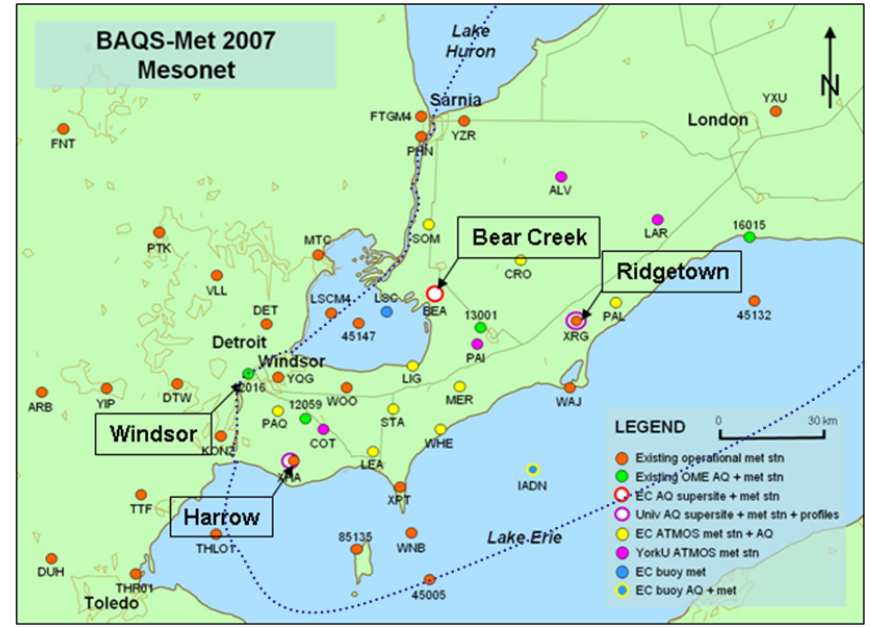
Fig. 1. Locations for the four atmospheric chemistry measurement super-sites (labeled in boxes) in southwestern Ontario, Canada during the BAQS-Met field campaign. Locations of existing and enhanced meteorological stations are also marked. Dotted line represents the US-Canada